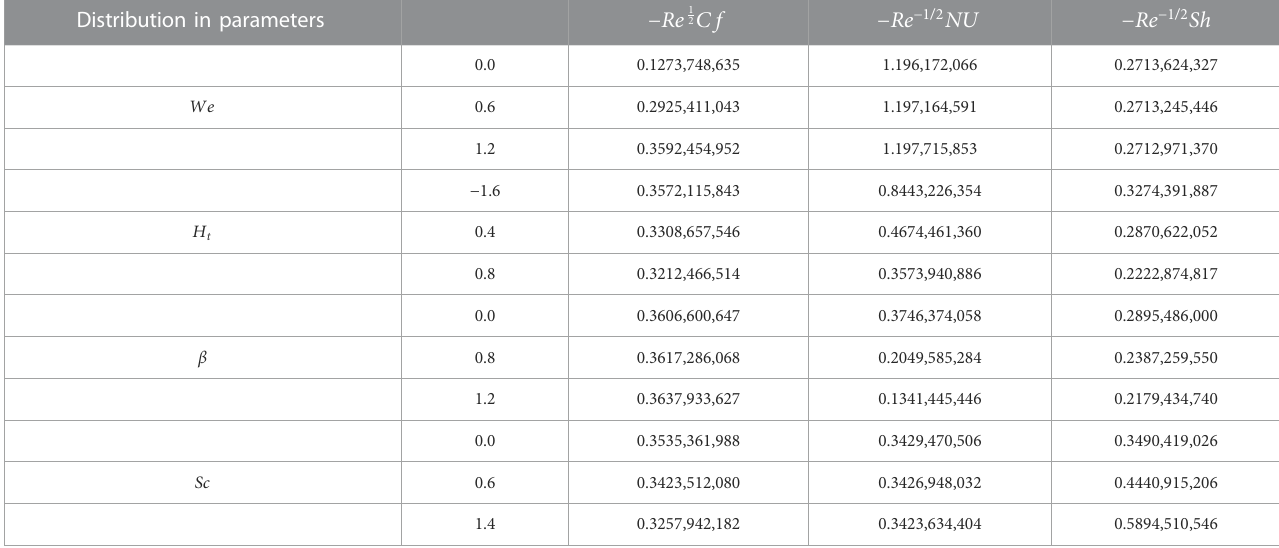
TABLE 5 Numerical behavior of We,H t , β , and Sc on fl ow gradient, concentration gradient, and temperature gradient when α (cid:2) 0 . 4 ,n (cid:2) 0 . 2 ,Re (cid:2) 2 . 0 , γ (cid:2) 0 . 2 , Λ (cid:2) 0 . 32 , Pr (cid:2) 5 , ϵ (cid:2) 0 . 1 , λ (cid:2) 0 . 4 , γ (cid:2) 0 . 4 ,K c (cid:2) − 1 . 5 , χ (cid:2) 0 . 3 , and τ (cid:2) 0 . 3 . Distribution in parameters